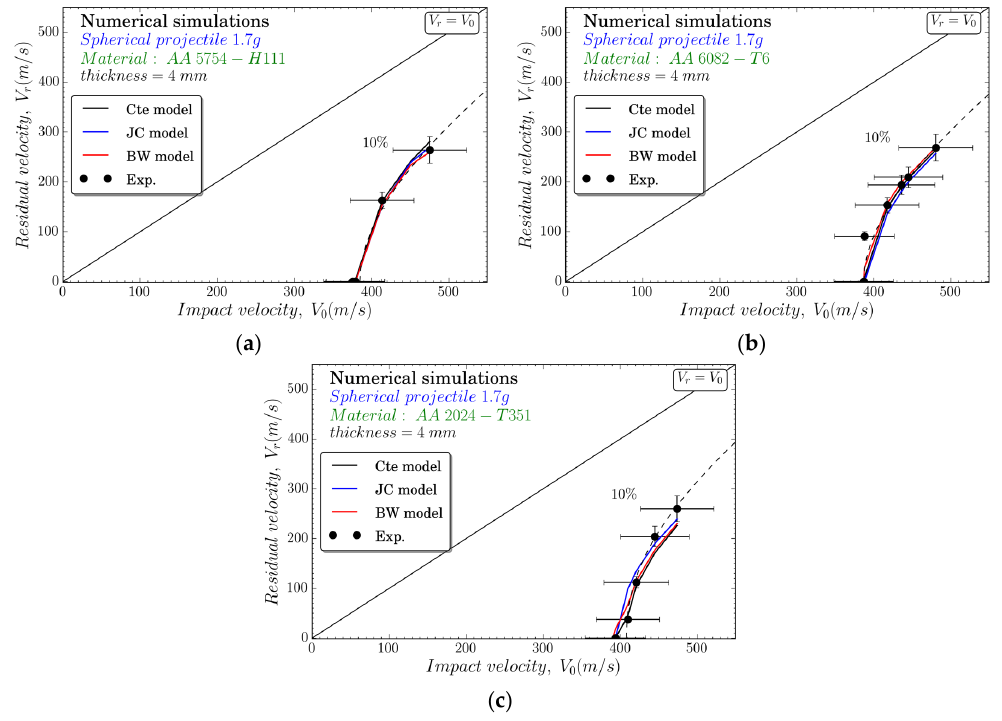
Figure 14. Spherical projectile configuration. Thickness = 4 mm. Comparison of residual velocity V r versus impact velocity V 0 between experiments and numerical simulations for: ( a ) AA 5754 ‐ H111; ( b ) AA 6082 ‐ T6; ( c ) AA 2024 ‐ T351.